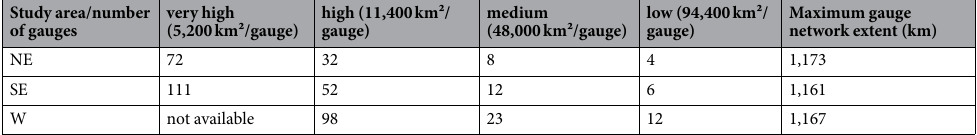
Table 1. Number of gauges for the three study areas, the four simulated precipitation gauge density scenarios referred to as ‘very high’, ‘high’, ‘medium’ and ‘low’, and the maximum extent of the networks in each